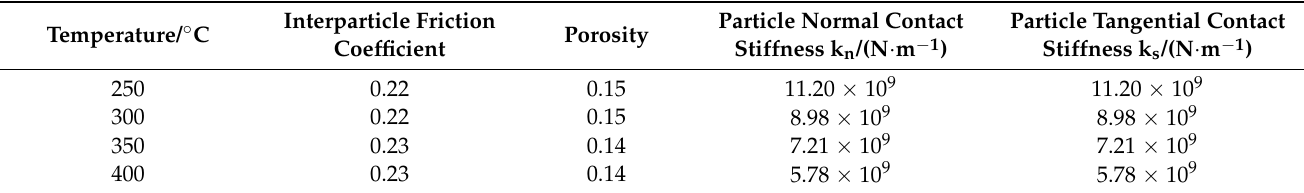
Table 3. Reservoir particles micromechanics parameters at different